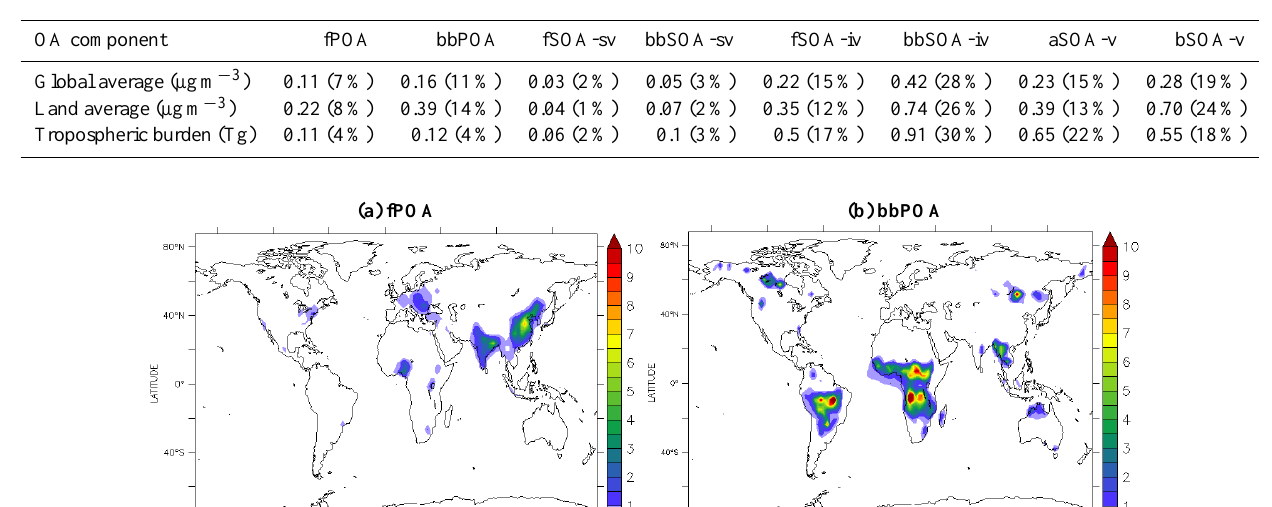
Table 7. Global and land average surface concentration and tropospheric burden of organic aerosol components. The fractional contribution of each component to total OA is listed in parentheses.